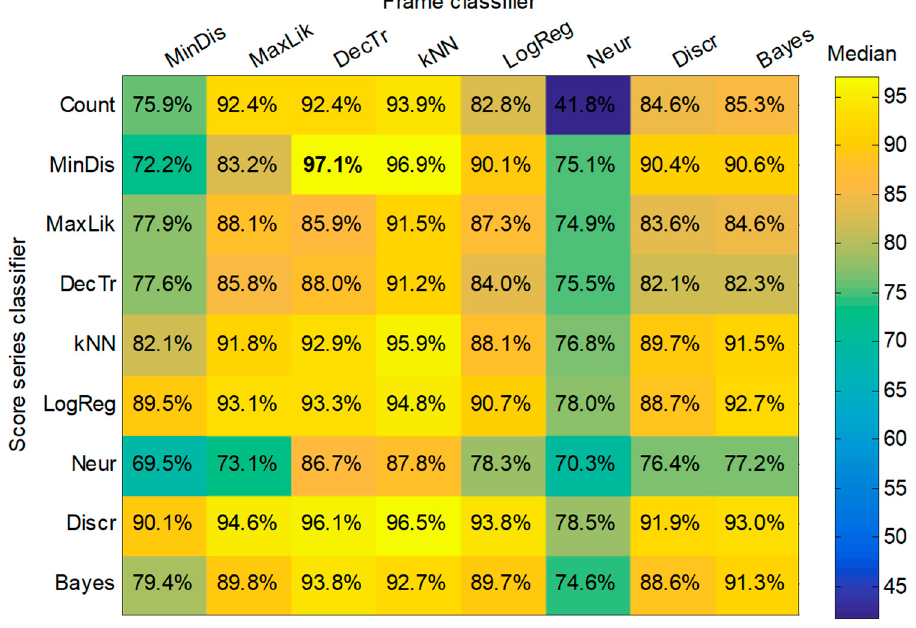
Table 7. Confusion matrix using the minimum-distance classifier operating on the score series obtained by the decision-tree frame